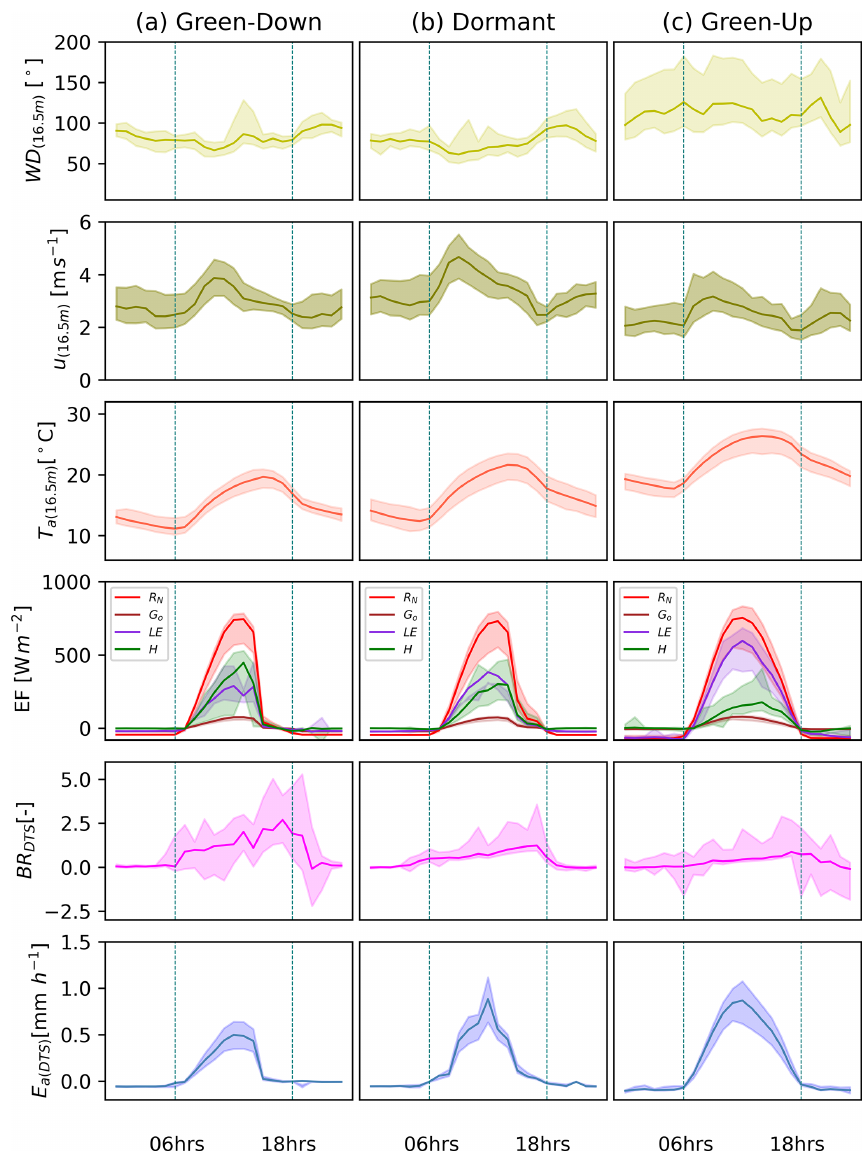
Figure 7. (a) Green-down, (b) dormant, and (c) green-up canopy phenophase-based hourly averages of wind direction (WD), wind speed ( u ), energy flux (EF) – net radiation ( R N ), ground heat flux ( G o ), latent heat flux ( LE ), and sensible heat flux ( H ) – Bowen ratio (BR DTS ), and actual evaporation ( E a ( DTS ) ). Shaded area is the standard